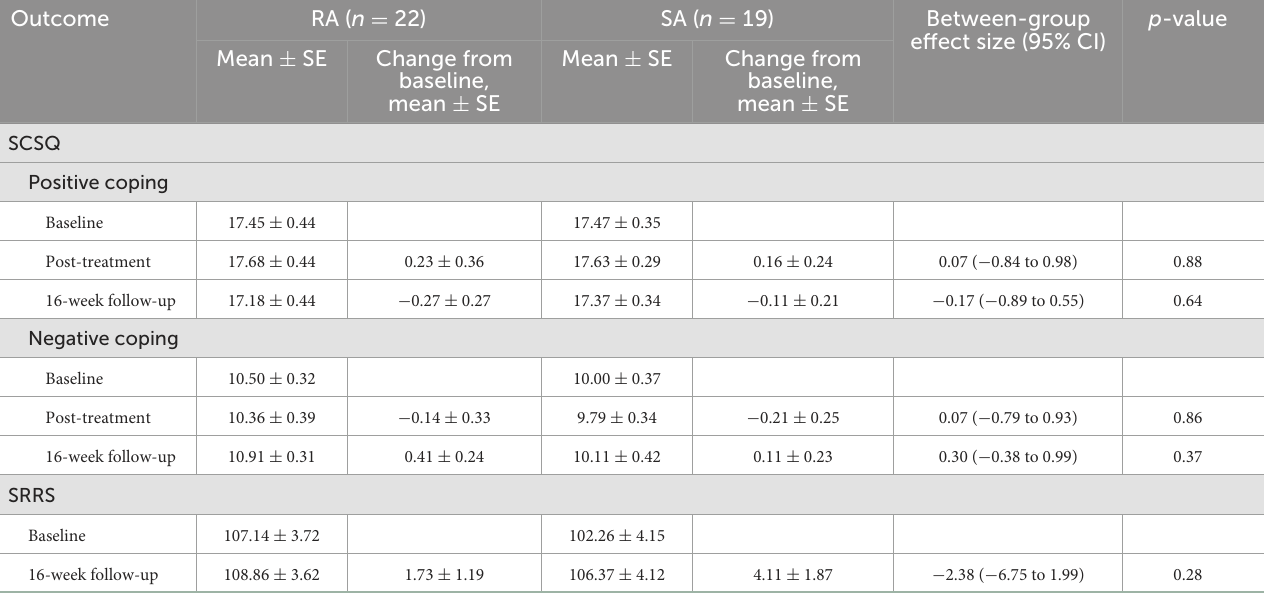
p -value effect size (95% CI)